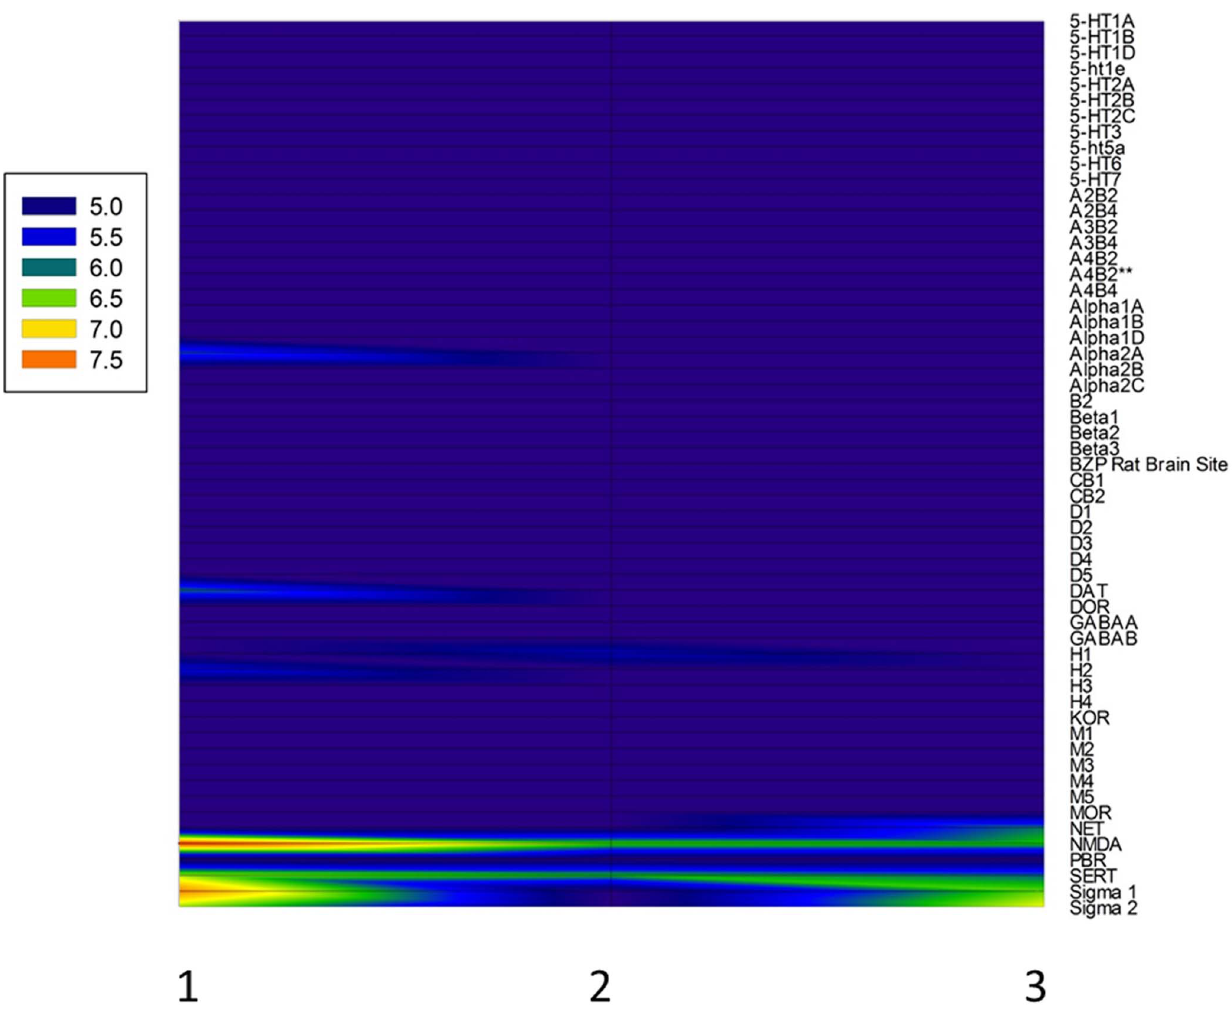
Figure 2. Mesh plot summarizing pharmacology of 3 novel PCP analogues. Shown in three dimensional mesh plot format are the pKi values of the three novel PCP analogues (3-MeO-PCE, 3-MeO-phencyclidine and 4-MeO-phencyclidine; 1, 2 and 3 respectively) against a panel of 56 molecular targets.